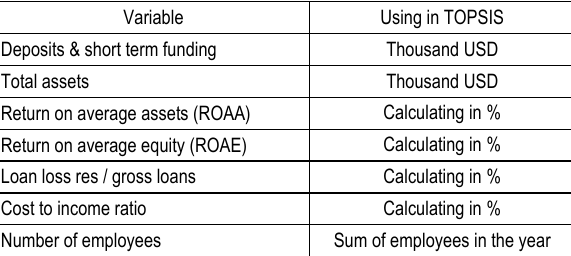
Table 2. All variables for TOPSIS